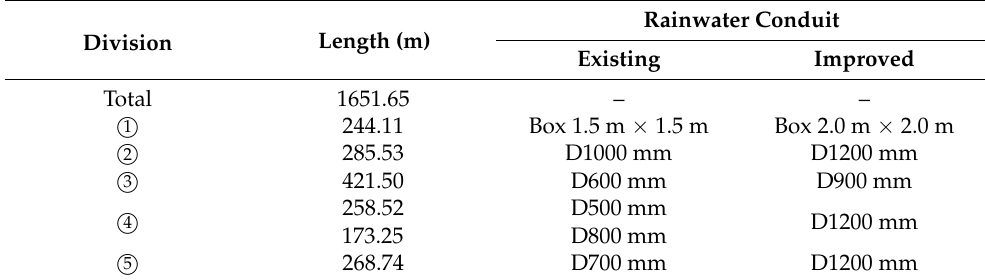
Table 7. Dowon watershed rainwater conduit improvement plan.